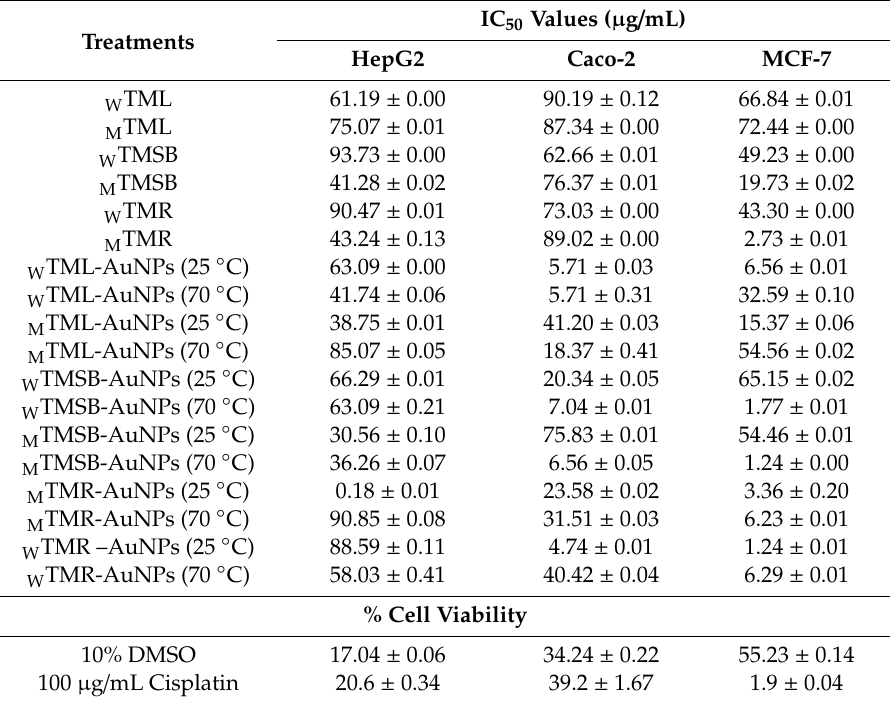
Table 5. IC 50 values of TM extracts and AuNPs against Caco-2, MCF-7 and HepG2 cells. Treatments